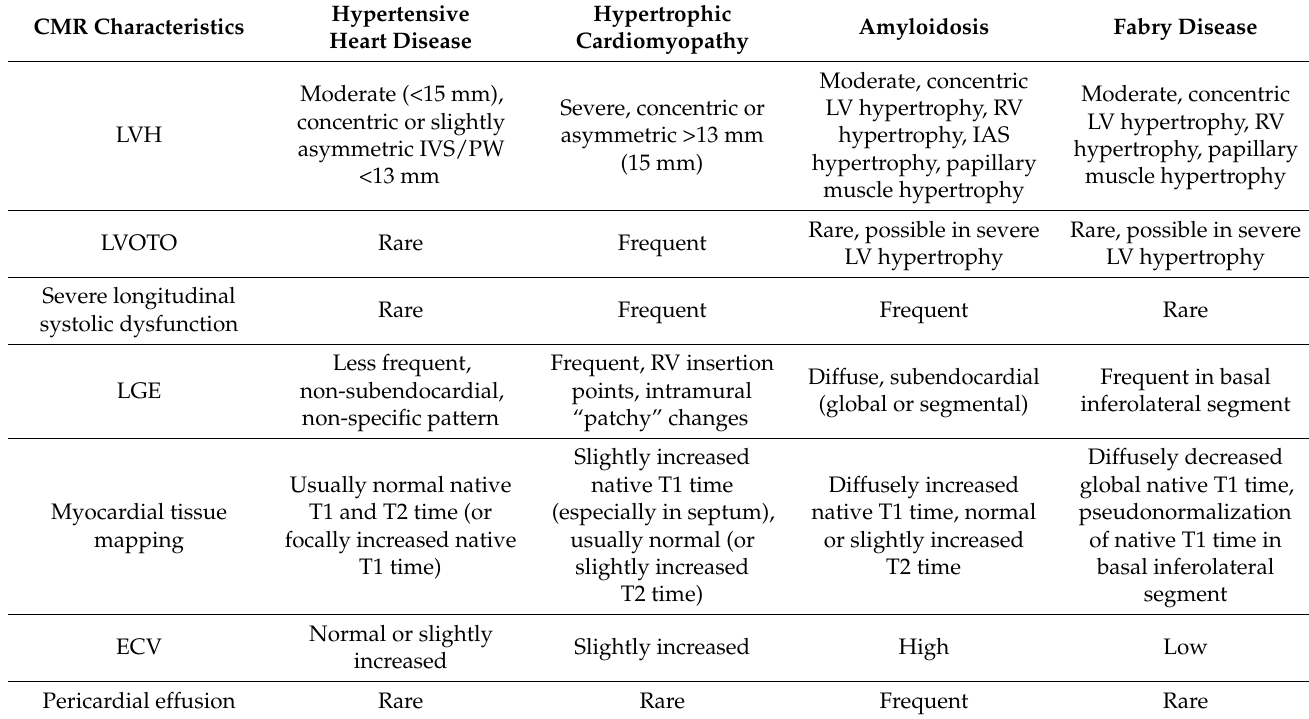
Table 2. CMR characteristics of various left ventricular hypertrophy